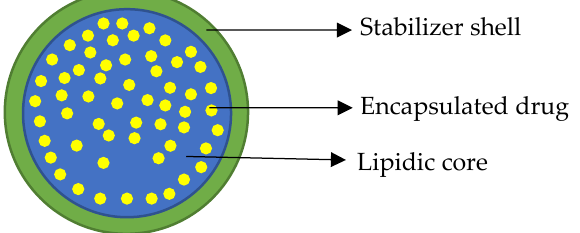
Figure 1. Schematic representation of loaded Solid Lipid Nanoparticles: a lipidic core (blue) with loaded drug (yellow) and a stabilizer outer shell (green).